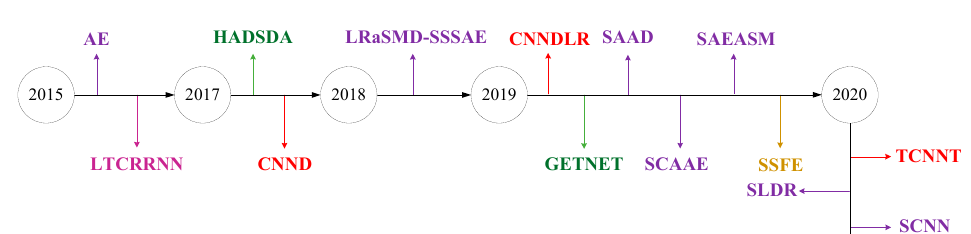
Figure 1. Network classification.